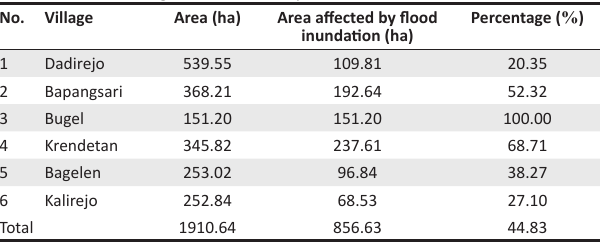
TABLE 2: The subvillage area affected by the flood inundation. No. Village